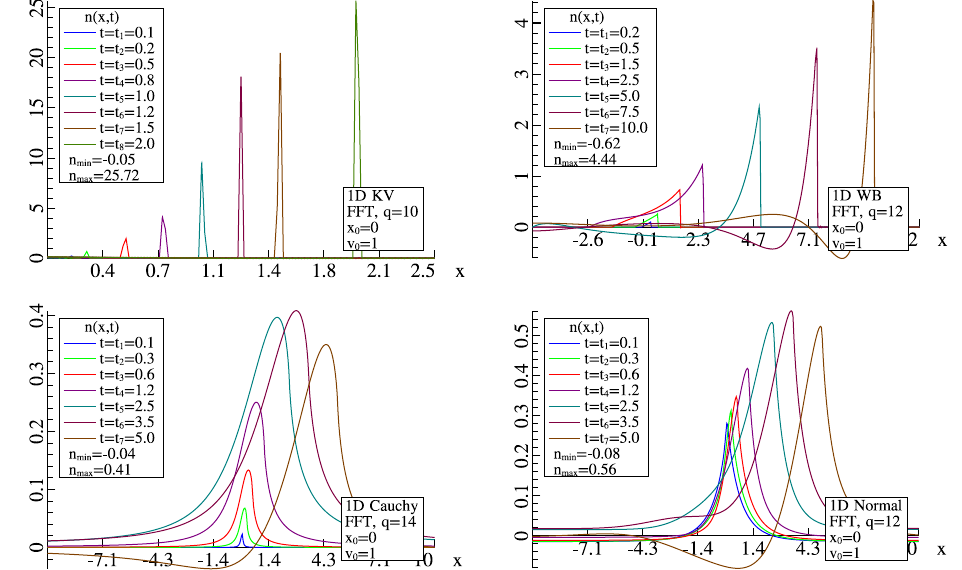
FIG. 2. The density n ð ~ x ; t Þ for the KV, WB, normal, and Cauchy distributions in 1D